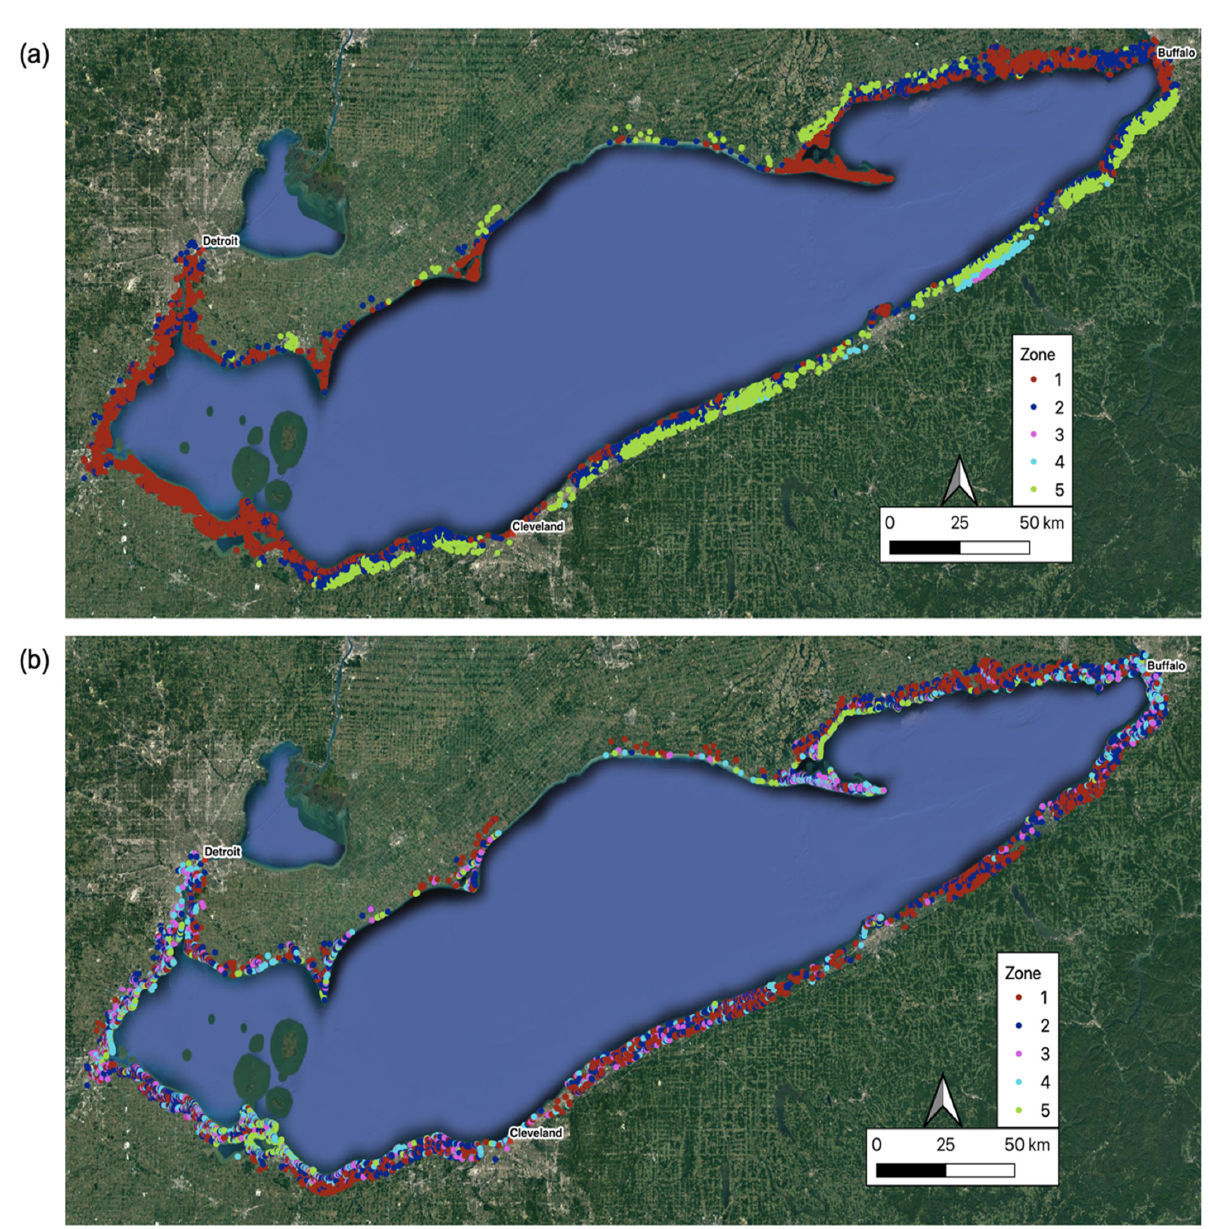
Figure 6. Results of the functional zonations: ( a ) map of Lake Erie’s all-metrics-based zonation; ( b ) map of Lake Erie’s EVI-based zonation.